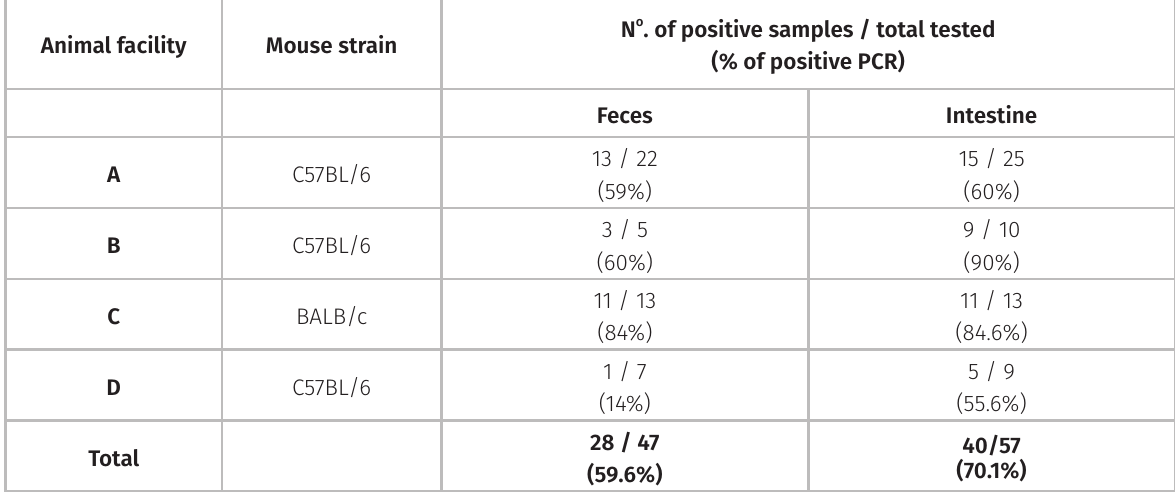
Table I. Percentage of Helicobacter spp. infected mice as determined by Helicobacter genus-specific PCR analysis.